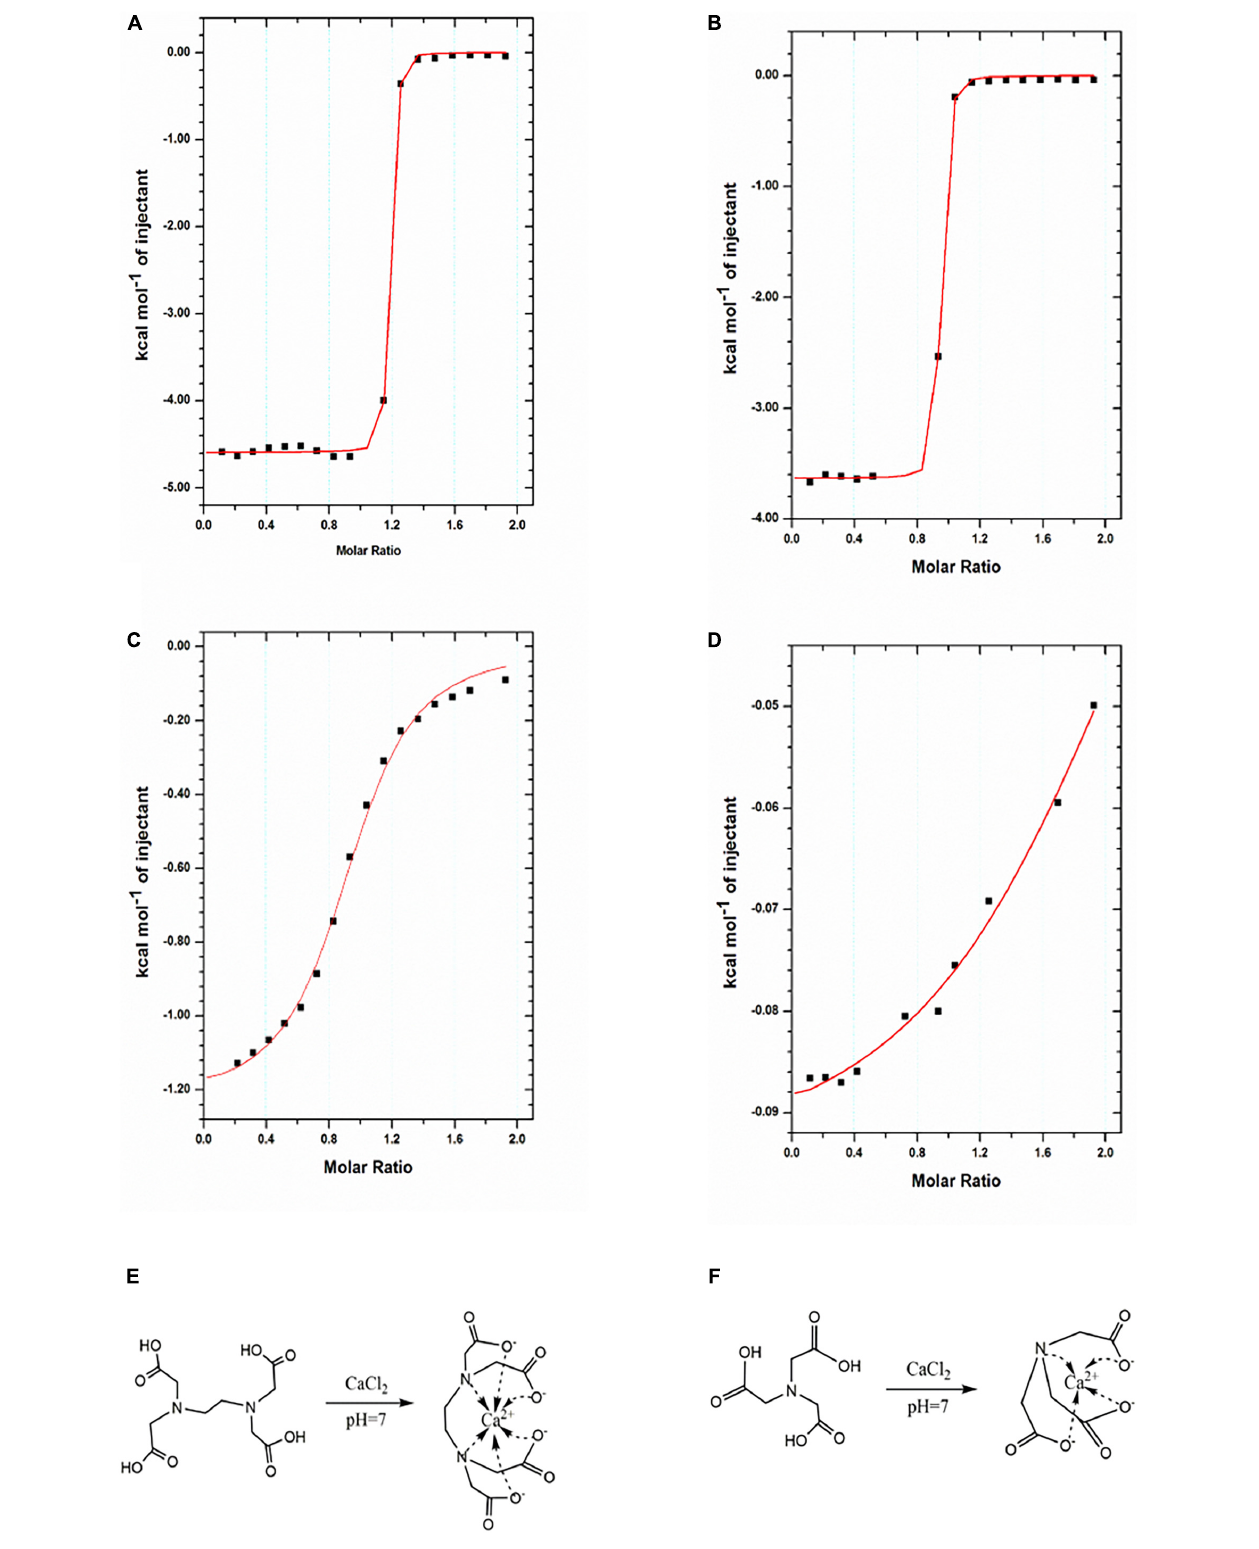
FIGURE 2 | Characterization of binding interactions by ITC. (A,B) ITC titration of EDTA (1 mM) with Ca 2 + ions (10 mM) at 25 ◦ C in pH 7 (A) and pH 6.5 (B) . (C,D) NTA (1 mM) with Ca 2 + ions (10 mM) at 25 ◦ C in pH 7 (C) and pH 6.5 (D) . The reaction schemes for the formation of the Ca-EDTA complex (E) and Ca-NTA complex (F) .